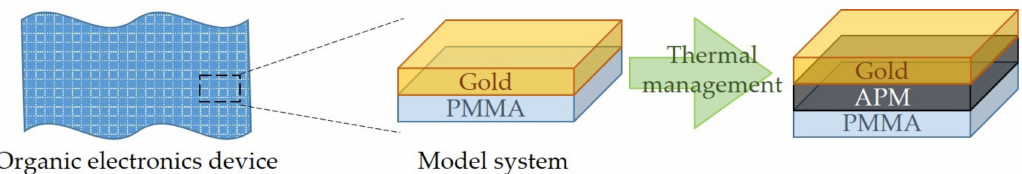
Figure 1. In organic electronics devices, there is an abundance of organic–inorganic interfaces such as the metal–polymer interface. A gold–polymethyl methacrylate (gold–PMMA) interface was chosen as the model system, and an adhesion promoting metal (APM) film was chosen as a way of improving heat transport in the